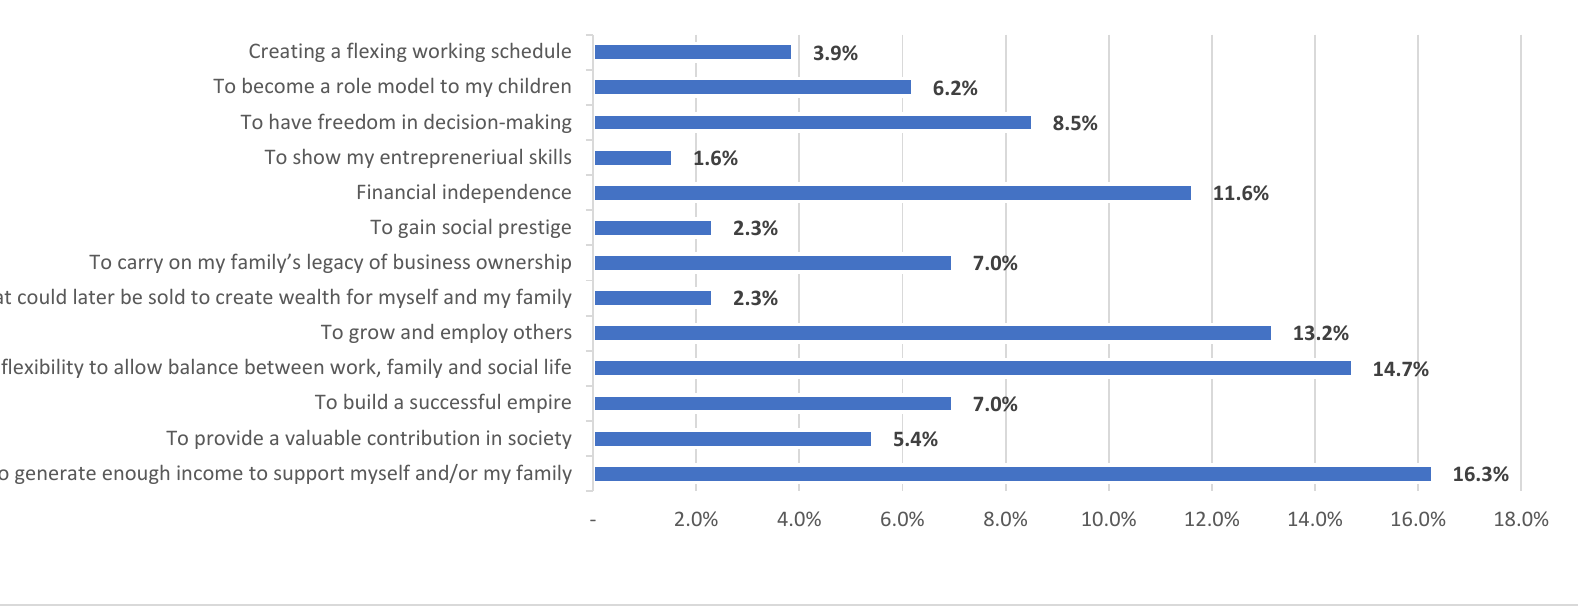
Figure 1. Motivation to start business (N = 36). Source: (authors(cid:31) own elaboration).